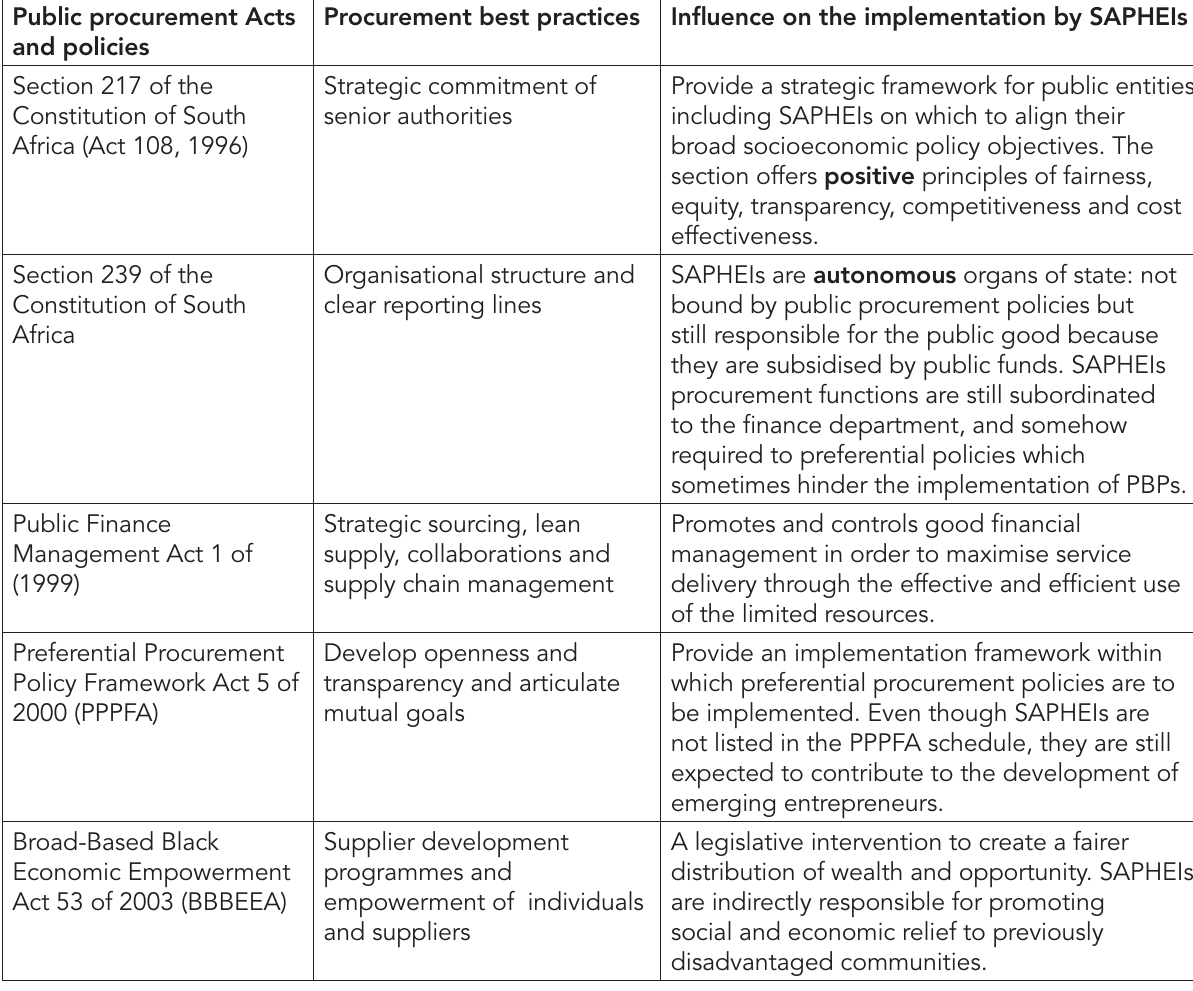
Table 2: Public procurement Acts and policies and the corresponding PBPs in SAPHEIs Public procurement